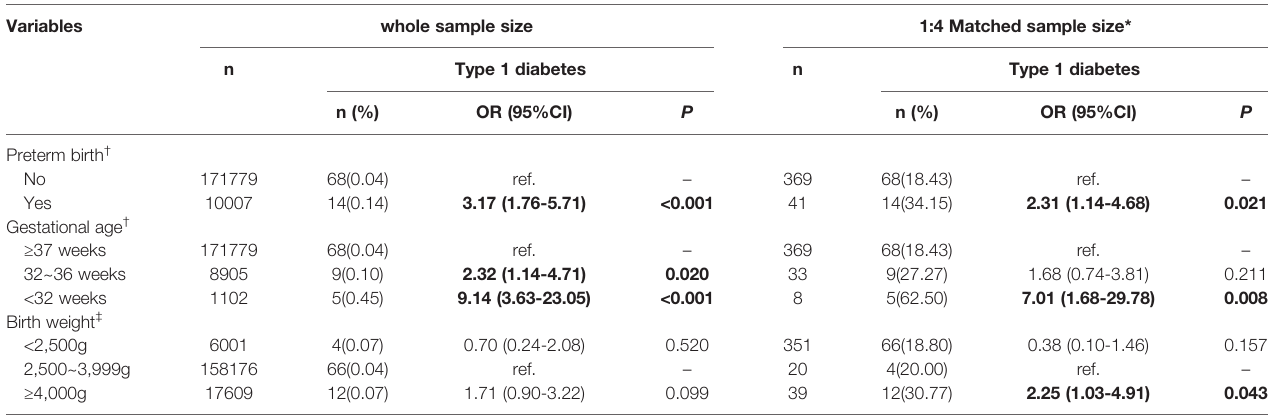
TABLE 2 | Associations of preterm birth and birth weight with Type 1 diabetes in Chinese children. Variables